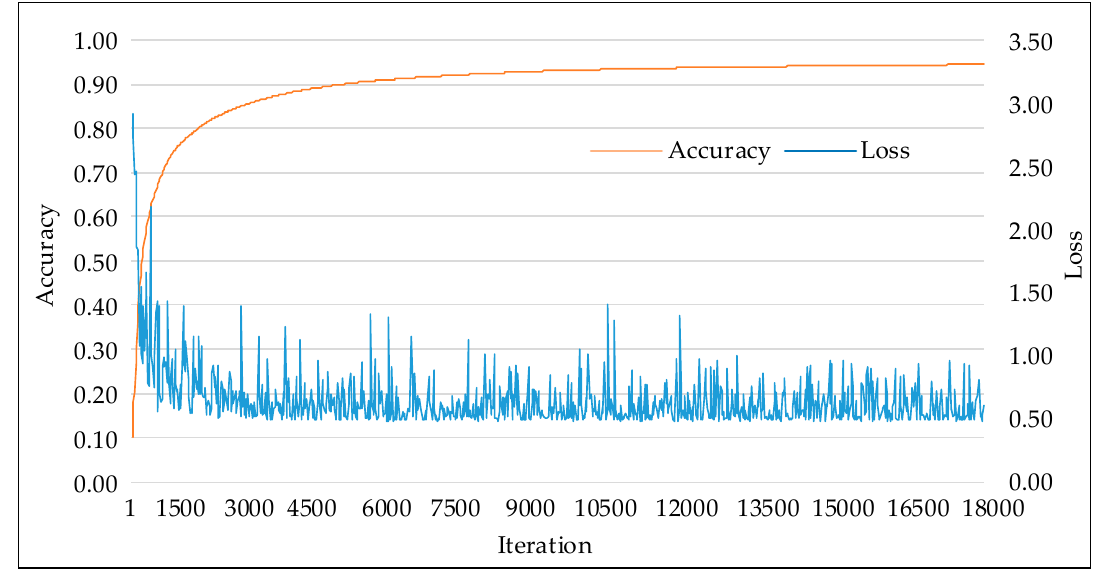
Figure 8. Re-training of the Inception-ResNet-v2 model.